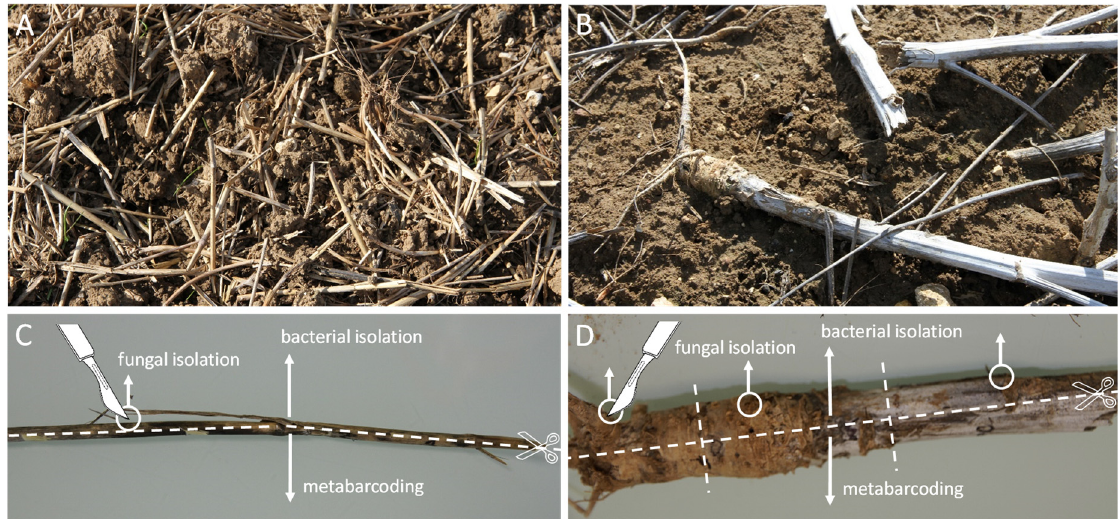
Figure 1. Sampling and preparation of crop residues. Wheat ( A ) and oilseed rape residues ( B ) on the ground in field plots. Wheat ( C ) and oilseed rape residues ( D ) cut lengthwise and selection of pieces of residue. For fungal isolation (total number of sample units = 1080, see Figure 2), we used one 1 mm 2 piece of residue cut from the first half section of each of 12 wheat residues and 3 × 1 mm 2 pieces of residue cut from the first half section of each of four oilseed rape residues (one piece from the stem base, one from the start of the pivotal root, and one piece from the collar); for bacterial isolation (total number of sample units = 15, see Figure 2), the rest of the first half section of residue was used for infusion. All the second half sections of the residues were used for metabarcoding